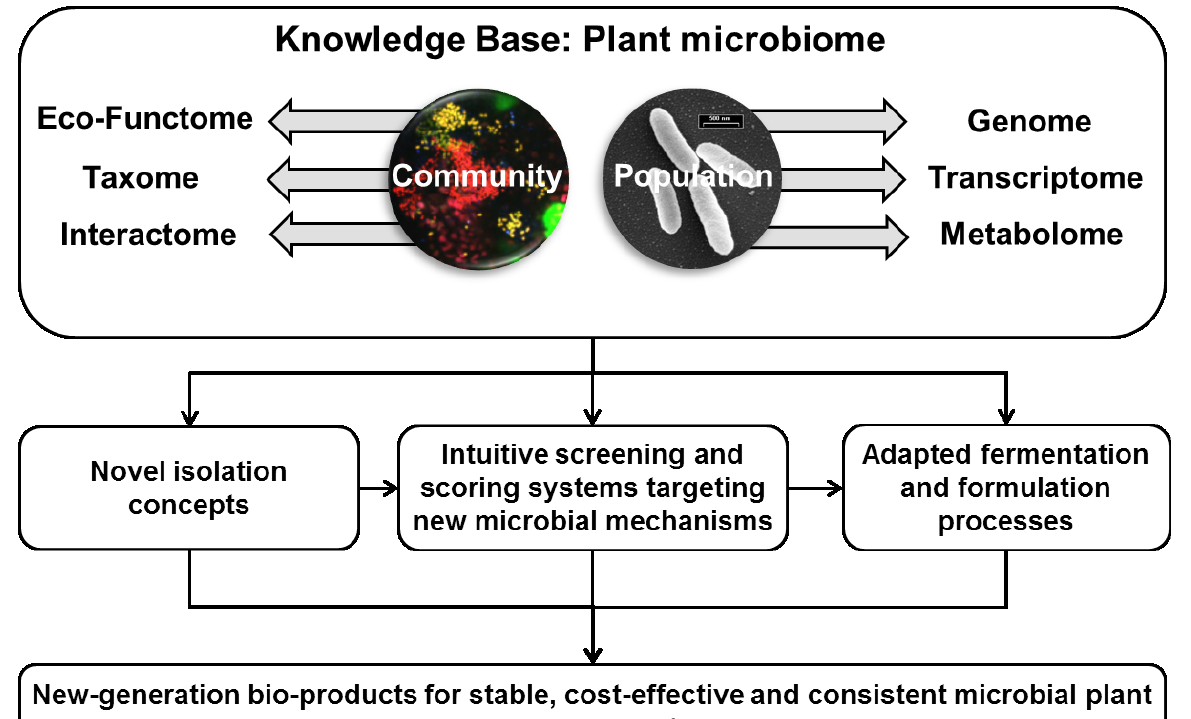
Figure 2. Knowledge-based and targeted development of next-generation